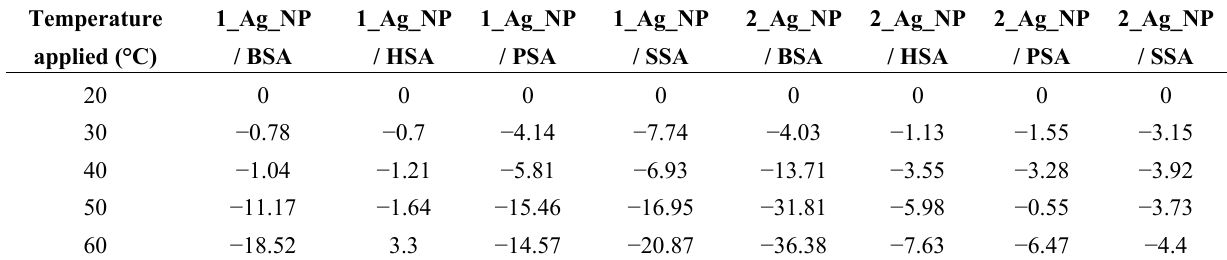
Table 5. Percentage changes of the maximum absorption of calixarene-capped silver nanoparticles as a function of temperature, after 15